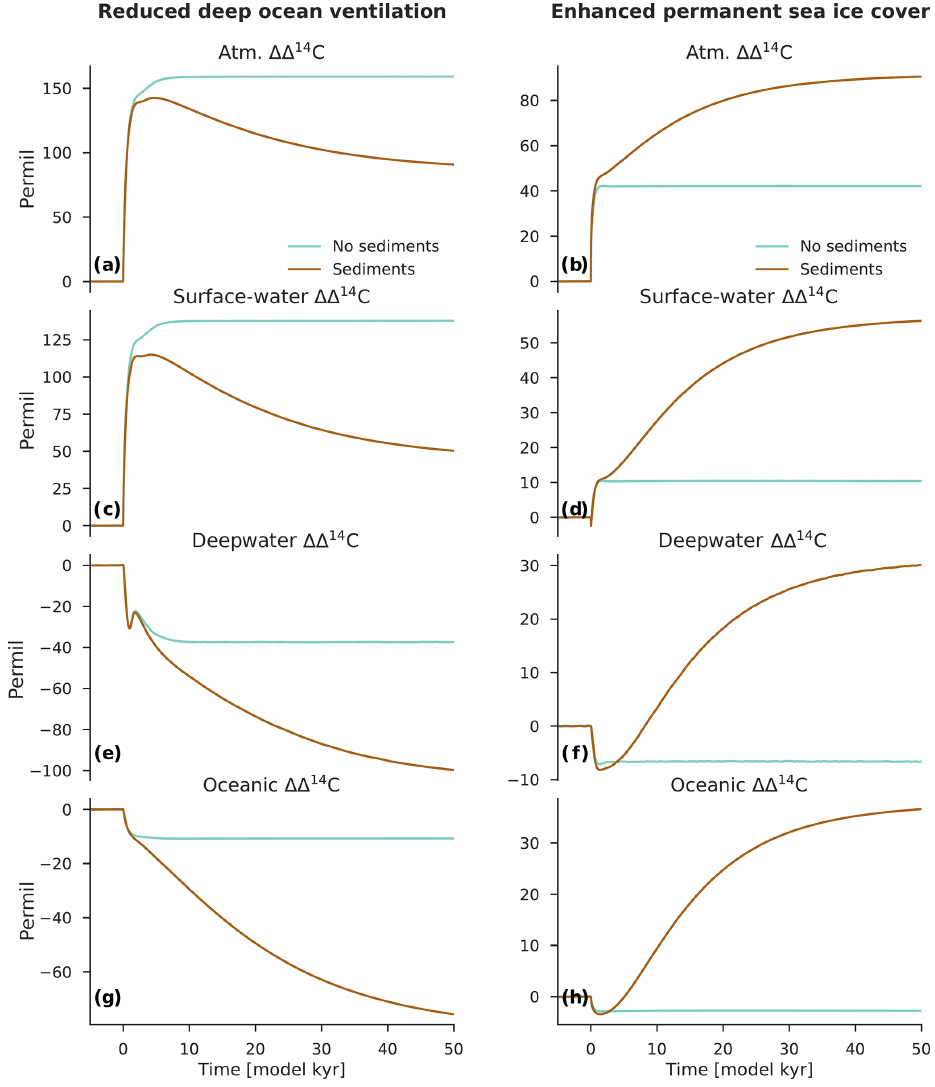
Figure 6. Change in (cid:49) 14 C for the atmosphere, surface ocean, deep ocean, and global ocean for the scenarios “reduced deep ocean ventila- tion” (a, c, e, g) and “enhanced permanent sea ice cover” (b, d, f, h) . Anomalies are expressed here as differences relative to the preindustrial steady state (in per mill). Turquoise lines show the model results using configuration OCN-LND (without sediments), and brown lines are configuration ALL (with